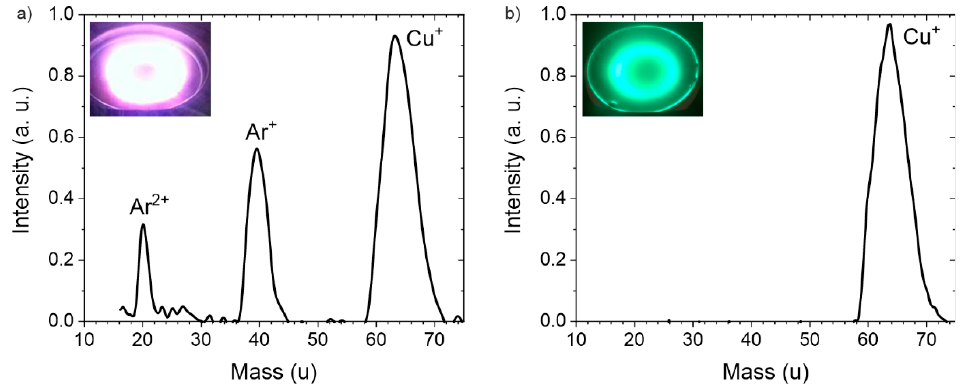
Figure 3. Mass spectra of ion flux in the substrate area: ( a ) magnetron with a cooled copper target; ( b ) magnetron with a hot copper target in gasless self-sputtering mode.